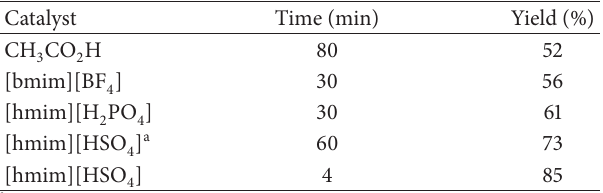
Table 1: Comparison of the catalytic activity of the catalysts. Catalyst Time (min) Yield